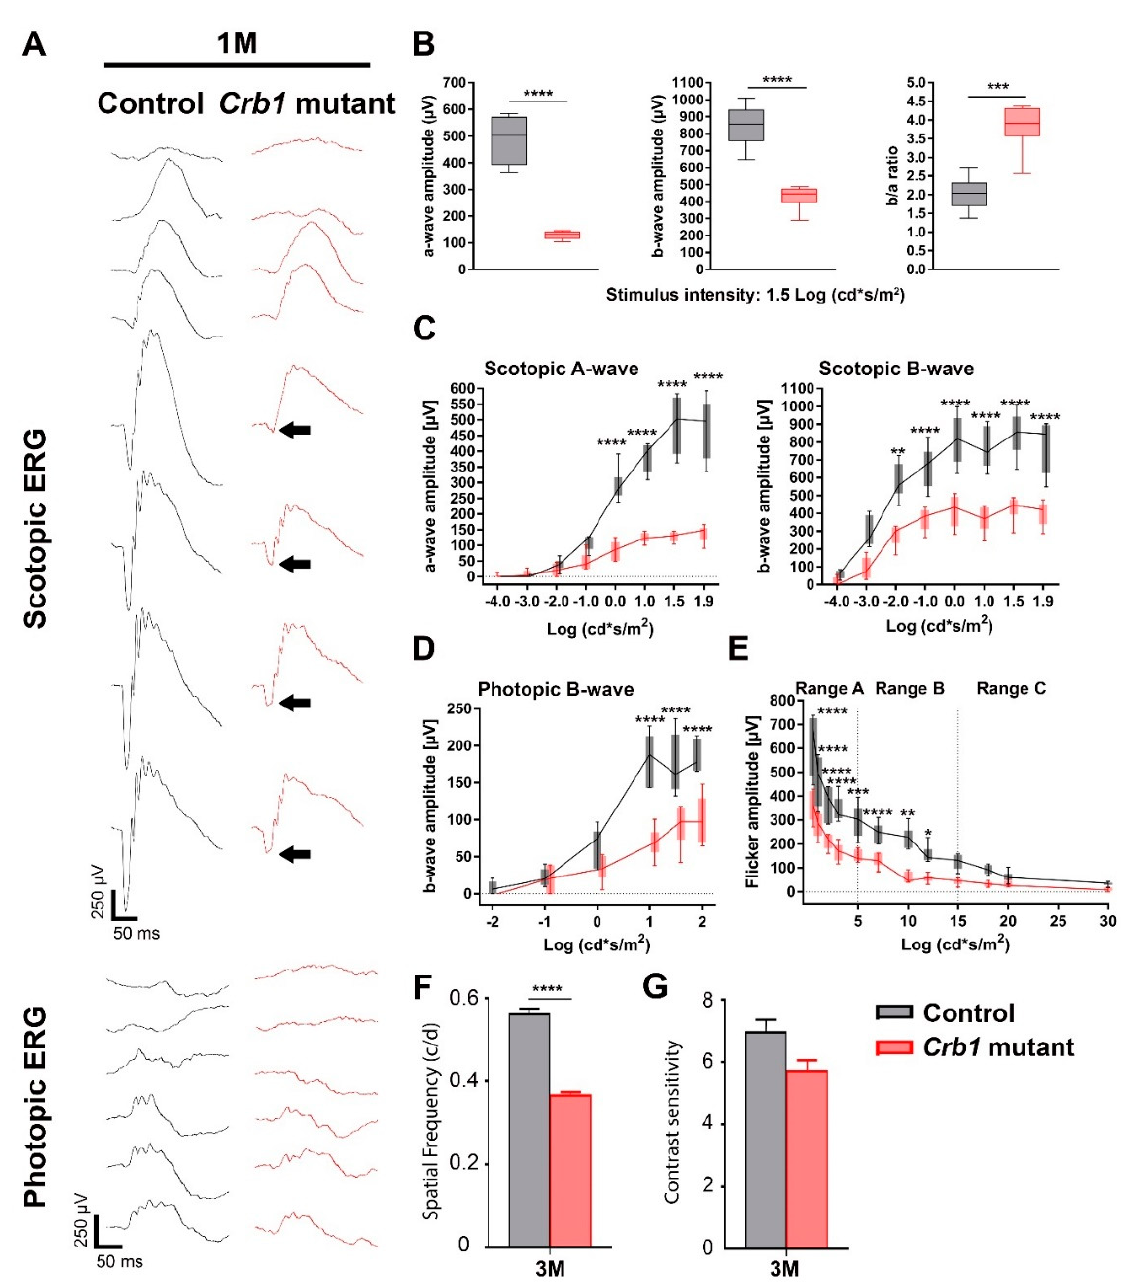
Figure 1. Significantly reduced retinal function in the Crb1 mutant compared to age-matched control rats. ( A ) Scotopic and photopic single-flash intensity series from representative rats at one month of age. The attenuated scotopic a-wave of the Crb1 mutant rats is indicated with the black arrow. ( B ) Quantitative analysis of the scotopic a-wave, b-wave and b-wave/a-wave amplitude ratio (b/a ratio). Quantitative analysis of the scotopic a-wave and b-wave ( C ), the photopic b-wave ( D ) and the flicker amplitude response ( E ). Boxes indicate the 25 and 75% quantile range and whiskers indicate the 5 and 95% quantiles, and the intersection of line and error bar indicates the median of the data (box-and-whisker plot). Decreased visual function in 3 months of age Crb1 mutant rats measured using the optokinetic head tracking response (OKT) spatial frequency ( F ) and OKT contrast sensitivity ( G ). Number of animals used for ERG: n = 6 for control and Crb1 mutant rats; and for OKT: control n = 4 and Crb1 mutant = 10. Mean ± SEM. * p < 0.05; ** p < 0.01; *** p < 0.001; **** p <